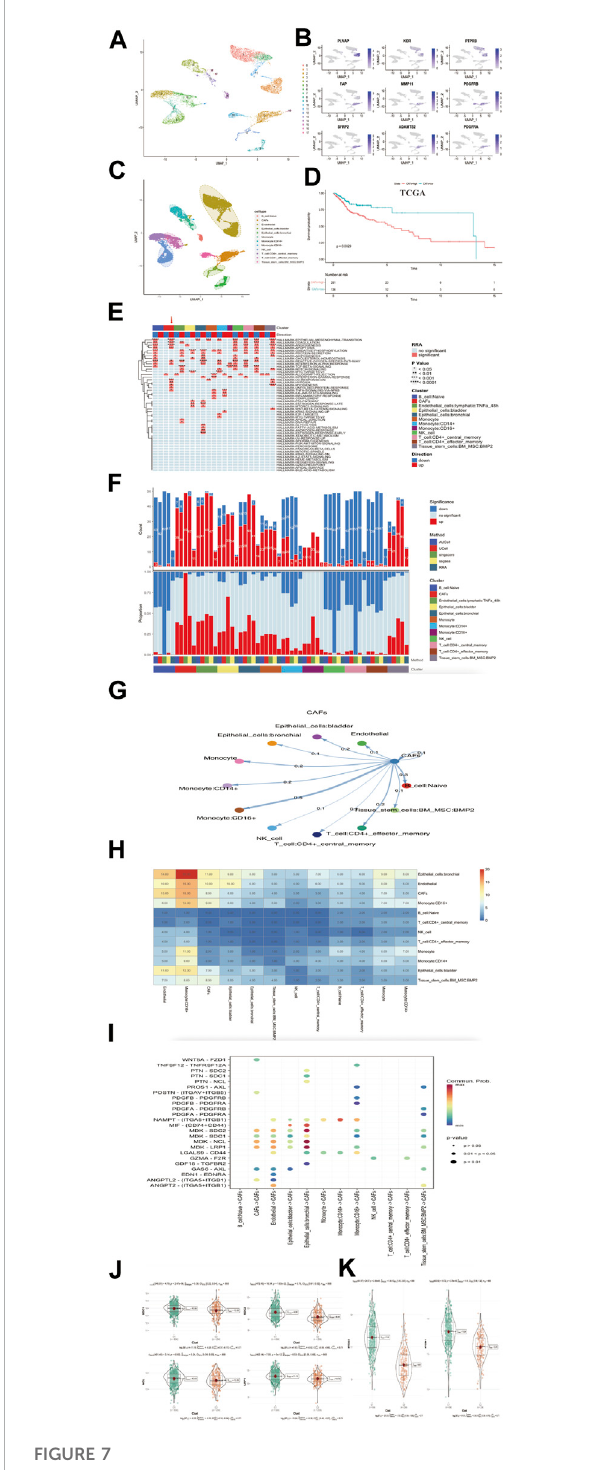
FIGURE 7 Veri fi cation of CafS clinical characteristic and biological function in single-cell RNA sequencing database (A) UMAP plot of selected 10244 single cells in tumor and non-immune stromal cells (CD45 negative). Different colors represent different cell types. (B) UMAP plot showed the expression of endothelial cell and cancer associated fi broblastscell. (C) UAMPplotofselected10244singlecells in tumor and non-immune stromal cells (CD45 negative). 18 cell clusters were divided into 12 cell types. (D) The Kaplan-Meier plot displays signi fi cant differences of survival time among the high-CAFs proportionandlow-CAFsproportioninTCGAcohorts.Deconvolution ( Continued